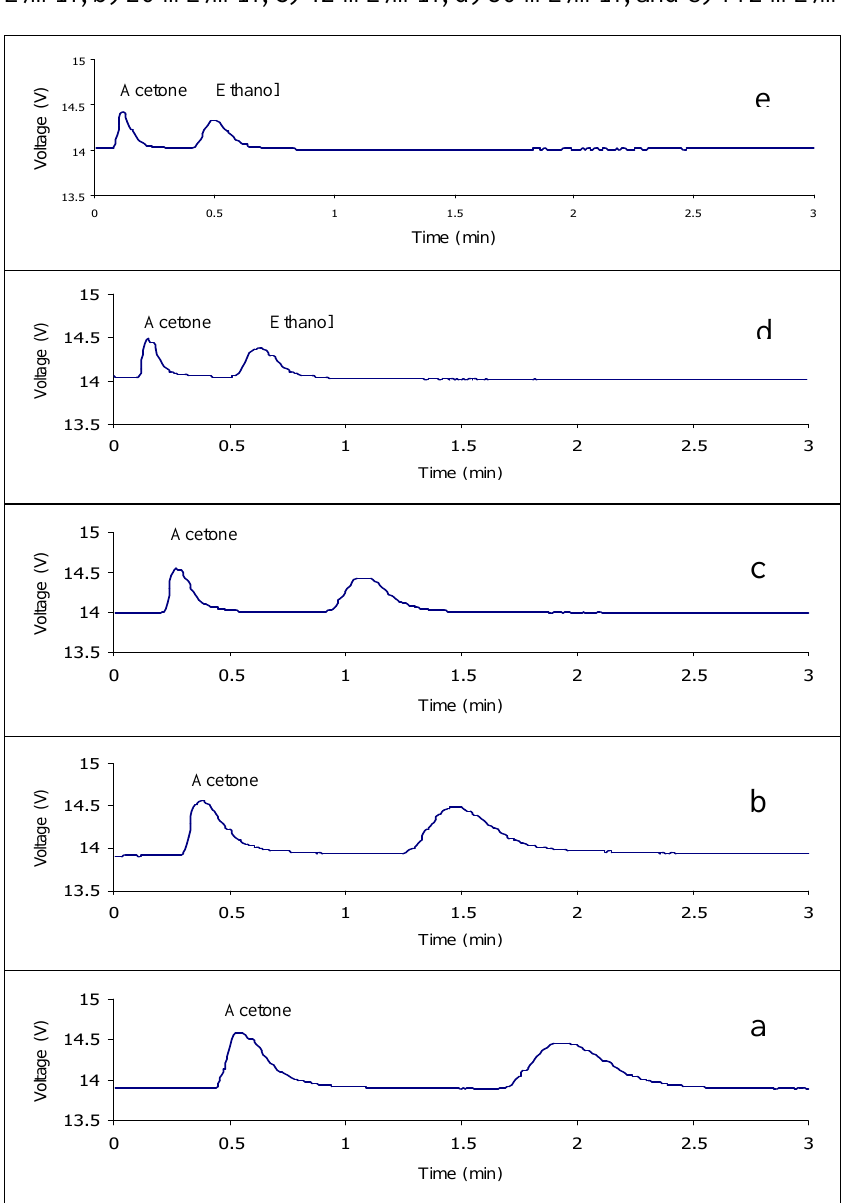
Figure 2. Chromatograms of mixed standard solution show the effect of the flow rate; a)